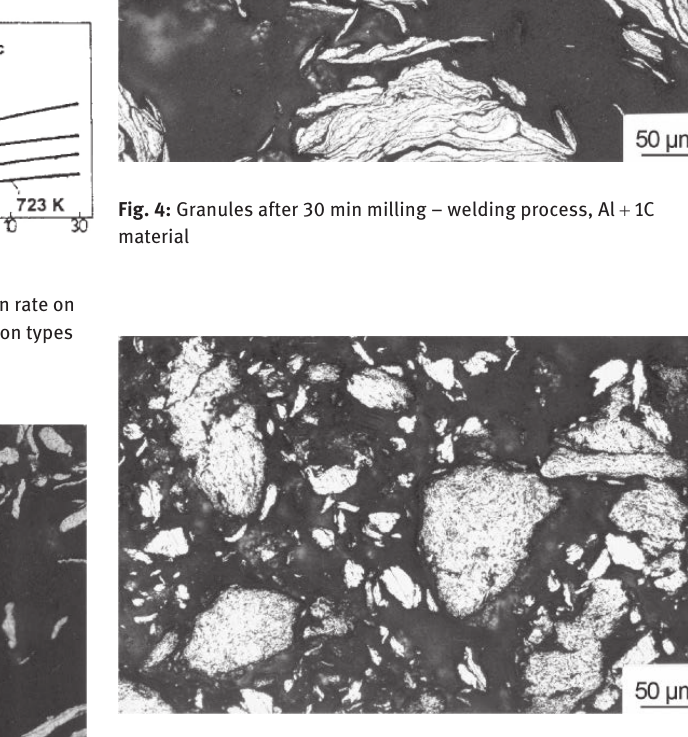
Fig. 5: State of granules after 60 min milling, Al + 1C material